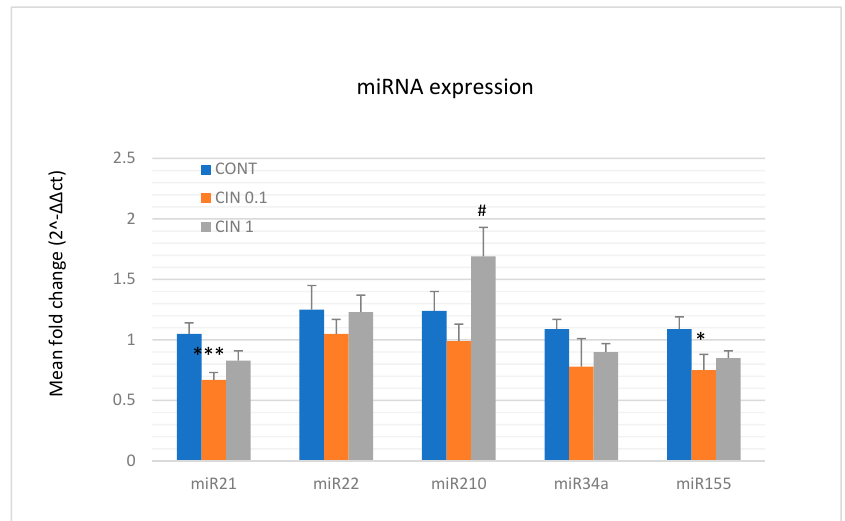
Figure 7. Relative miRNA expression of miR21, miR22, miR210, miR34a, and miR155 in rat mammary carcinomas. MiR-191-5p was selected as the internal control miRNA to normalize the cDNA levels of the samples. Data are expressed as mean ± SEM. Significant di ff erence, * p < 0.05, *** p < 0.001 vs. CONT, # p < 0.05 vs. CIN